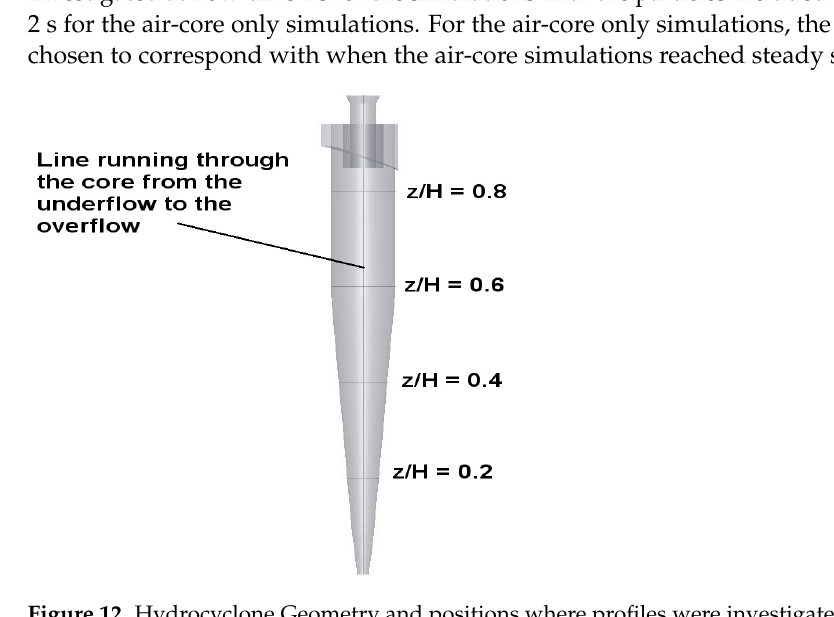
Figure 12. Hydrocyclone Geometry and positions where profiles were investigated.